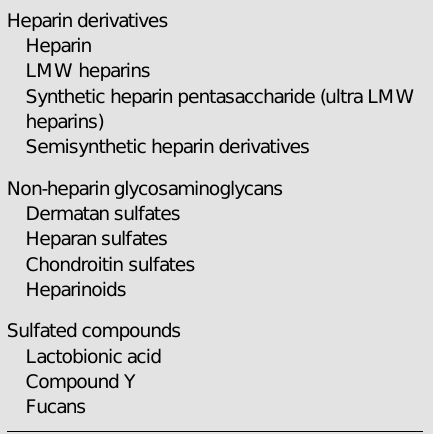
Table 3. Antithrombotic sulfated compounds (ap- proved or under